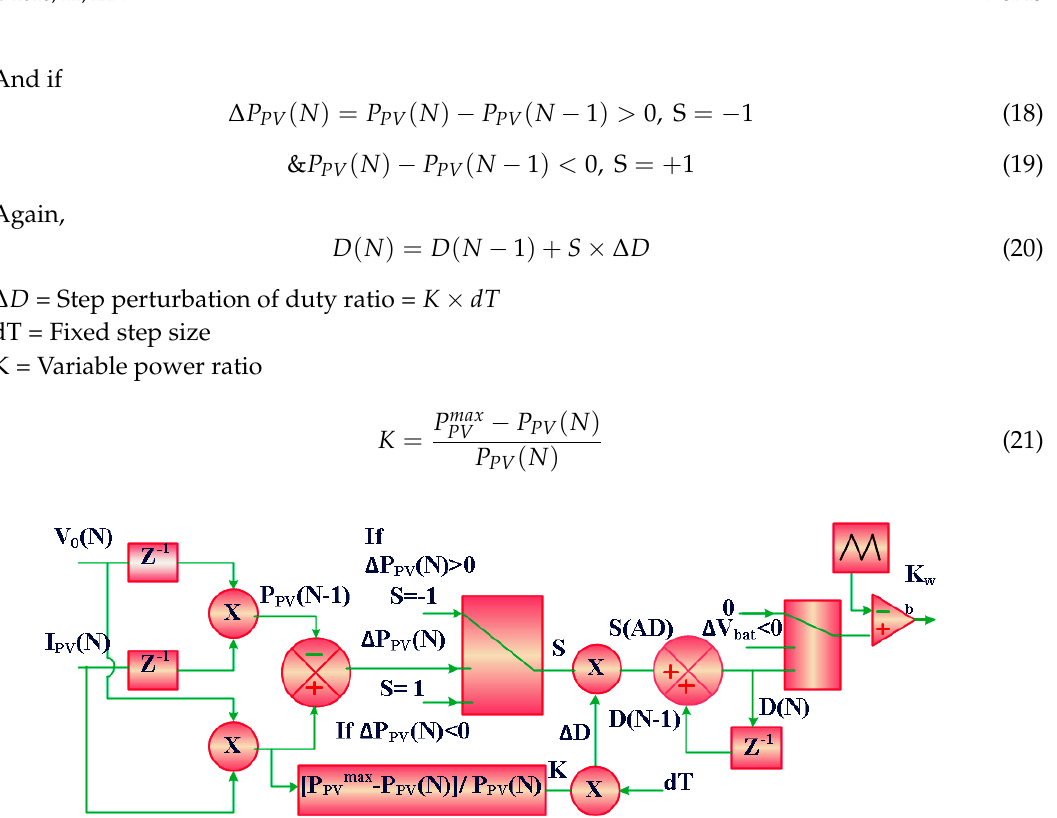
Figure 6. Working model of MPRVS based P&O technique.